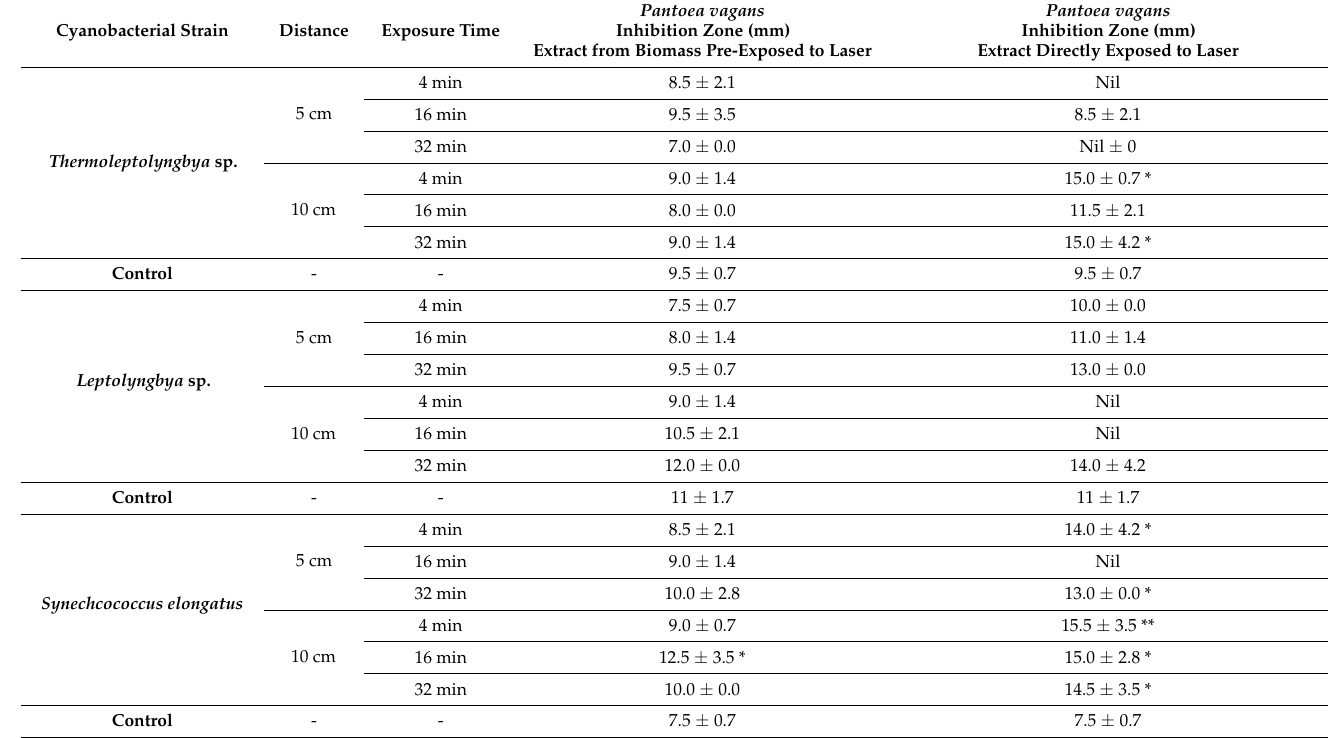
Table 1. Effect of interaction between distance and time intervals as functions of laser dose treatment on the antimicrobial effect of cyanobacterial extracts derived from cyanobacterial biomass pre-exposed to laser and extracts directly exposed to laser. Experiments were carried out in